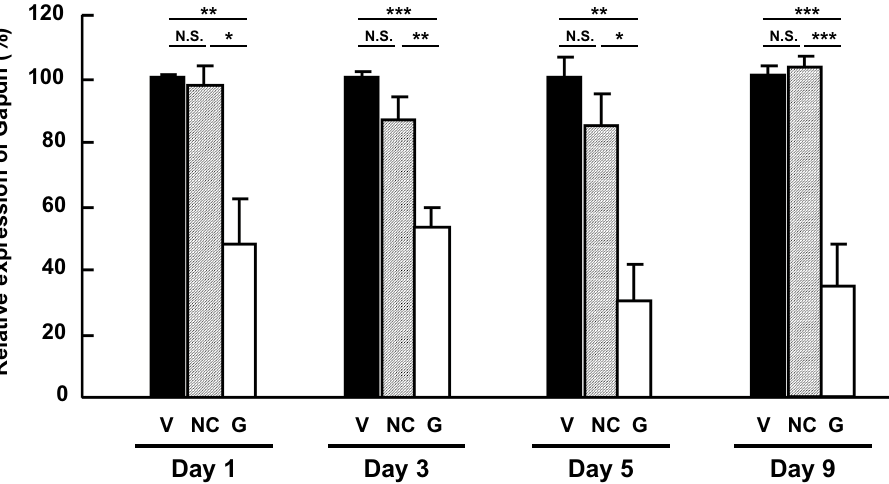
Figure 1. Time-gene silencing profiles following intravitreal injection of Accell siRNA targeting Gapdh in the rat retina. Gene expression of Gapdh was measured by means of quantitative real-time PCR at 1, 3, 5 and 9 days after intravitreal injection of vehicle, negative control siRNA (2 nmol/eye for Day 1 and 5 nmol/eye for Day 3, 5 and 9), or siRNA (2 nmol/eye) targeting Gapdh . Gene expression of Gapdh was normalized to that of Actb and is shown as the percentage of the respective control value in the vehicle-treated group. Each value represents the mean ± S.E.M. for n = 3–6. * P < 0.05; ** P < 0.01; *** P < 0.001, by Tukey’s multiple comparison test. N.S. represents not significant. Vehicle (V), closed column; negative control siRNA (NC), gray column; Gapdh siRNA (G), open